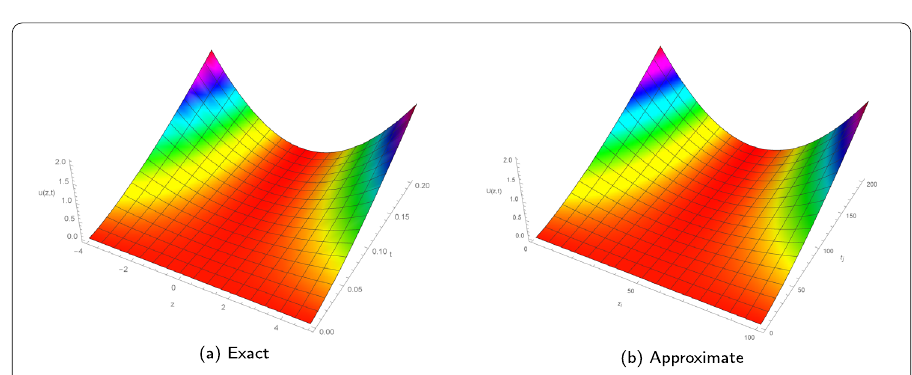
Figure 4 Exact and numerical solutions for Example 1 when N = 100, α = 0.4, t = 0.2, (cid:3) t = 0.01, and –4 ≤ z ≤ 5